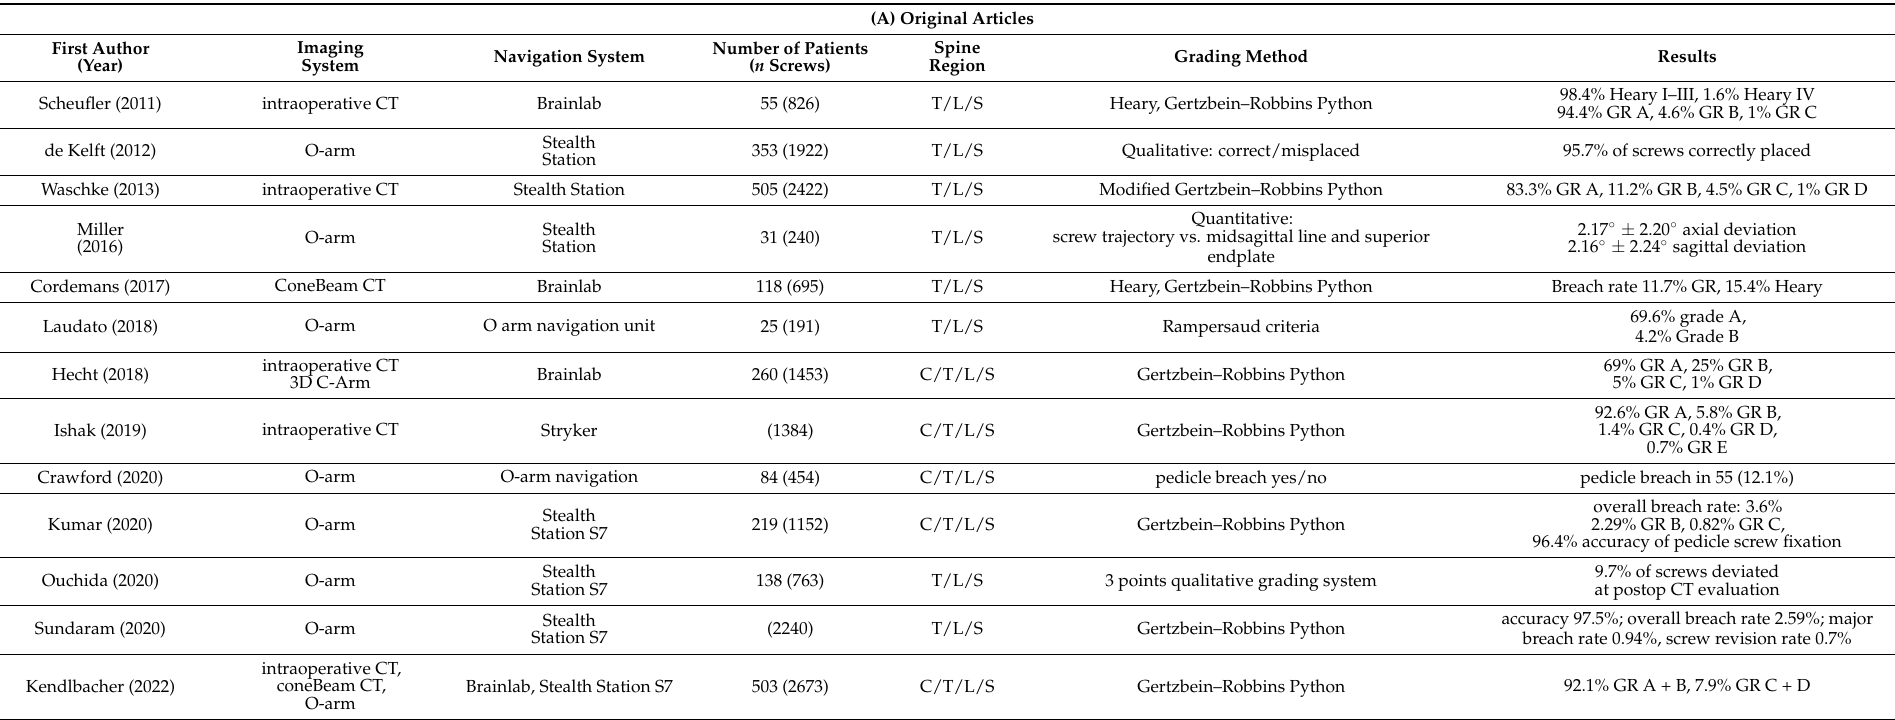
Table 3. Review of the recent literature on pedicle screw accuracy in navigated lumbosacral instrumentation based on intraoperative imaging. (A) Original